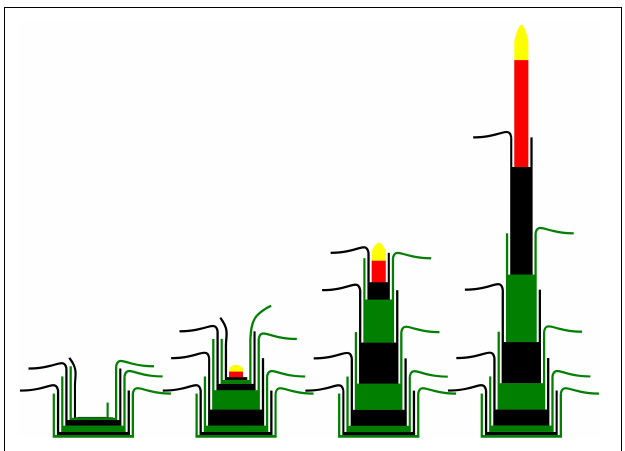
FIGURE 3 | Schematic representation of leaf appearance, internode elongation and heading of a reproductive tiller (adapted from Gillet, 1980). Green and black phytomers represent successive phytomers. Red internode is the peduncle. Yellow structure is the